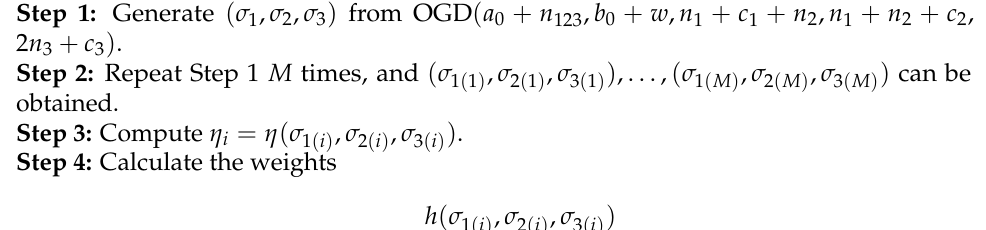
Algorithm 2 The Bayesian estimate for η ( σ 1 , σ 2 . σ 3 ) with order